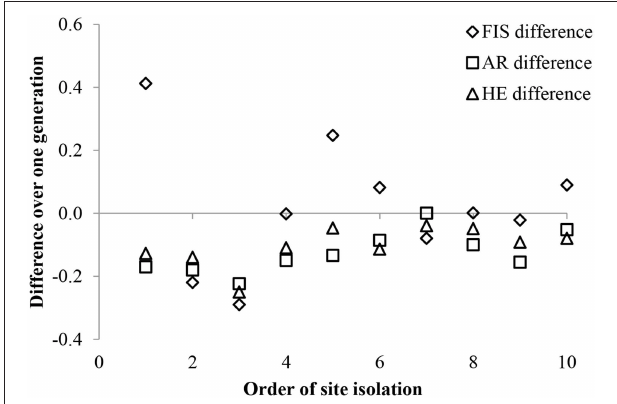
FIGURE 2 | The difference in inbreeding (F IS ) between offspring and parental generations varied by site and was not related to proximity to neighboring populations of P. hirsutus on 10 green roofs. Both average allelic richness (A R ), and expected heterozygosity (H E ) were lower in offspring than parental generations in all populations. Data for the populations are arranged by their relative degree of isolation compared to the other populations in the study. There were no significant linear relationships detected between the mean distance to other populations and F IS ( p = 0.783), A R ( p = 0.889), or H E ( p =